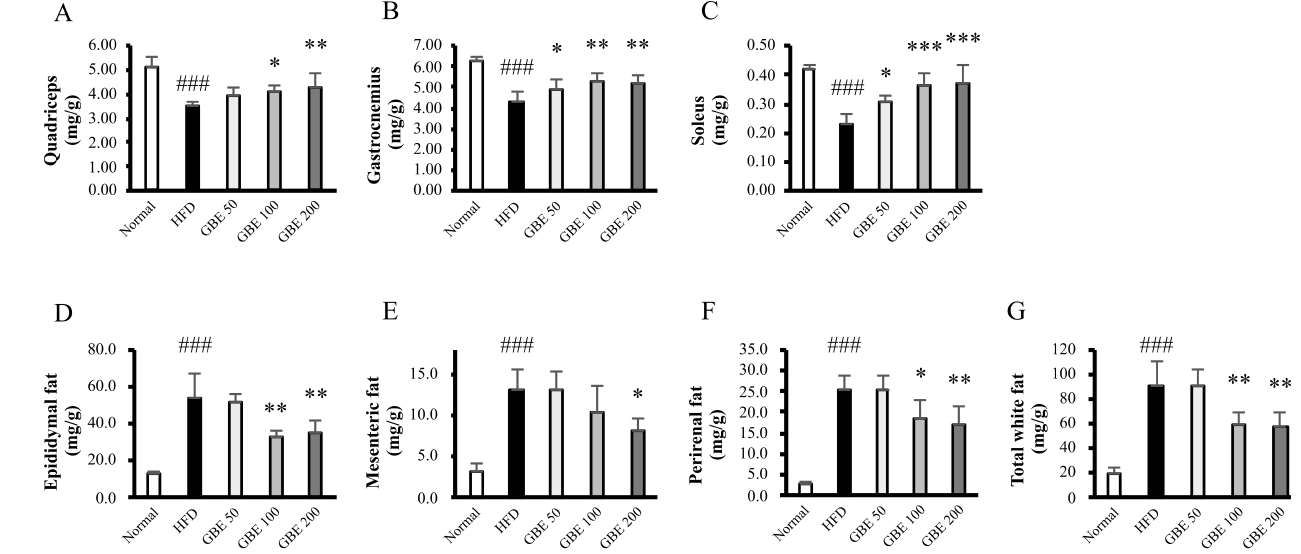
Figure 1. GBE administration significantly decreased food efficiency ratio and increased grip strength. ( A ) The body weight (g) during an animal experiment. ( B ) The food efficiency ratio (FER, %). ( C ) The grip strength (g/g) during an animal experiment. It was expressed as a ratio of grip strength to body weight. Data are expressed as mean ± SD. ## p < 0.01 and ### p < 0.001 versus the normal group. * p < 0.05 versus the HFD group. 4/29/22, 2:47 PM